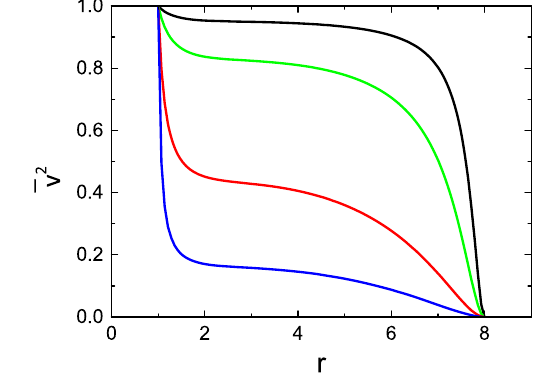
Fig. 5 (Squared) Speed ¯ v 2 (Eq. 46) of a uniformly accelerated par- ticle inside the horizon of the RN BH for α = 1; 0 . 5; 0 . 2; 0 . 1 (black/green/red/blue) ( M = 5, Q = 3)